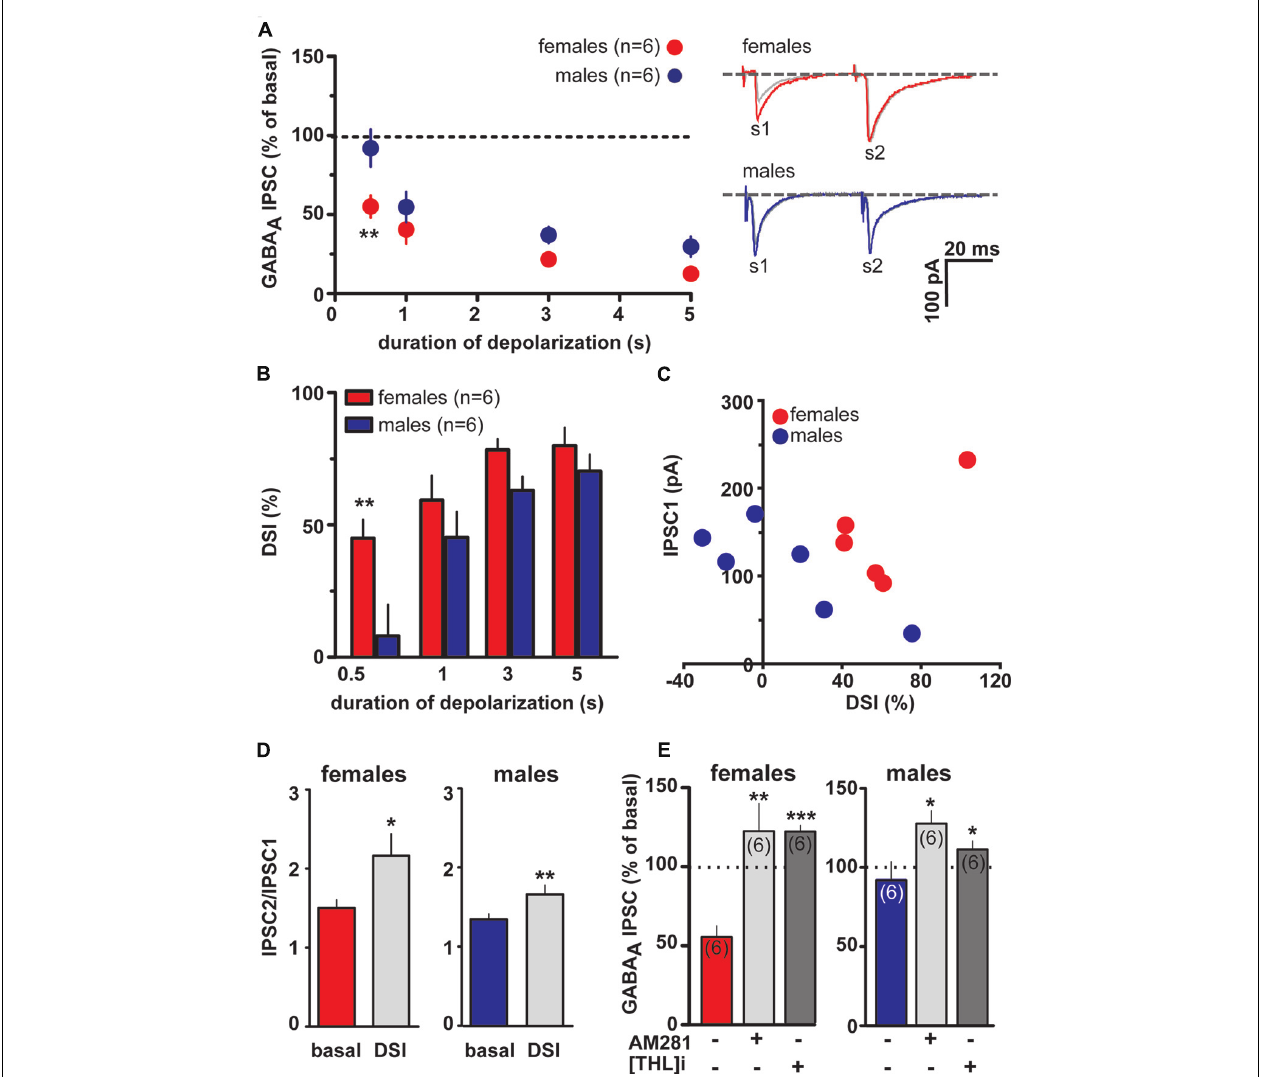
FIGURE 4 | Endocannabinoid modulation of inhibitory transmission arising from caudal afferents is reduced in male LH rats. (A) The relationship between the depolarizing pulse duration and the relative amplitude of GABA A IPSCs obtained after 5–15 s after the end of depolarization is plotted (left panel). GABA A IPSCs amplitude was normalized to the averaged value (dotted line) before depolarization. Each symbol represents the averaged value obtained from different cells. Representative traces before and after DSI (0.5 s) are overlaid and shown (right panel). Gray traces represent the GABA A IPSCs after the